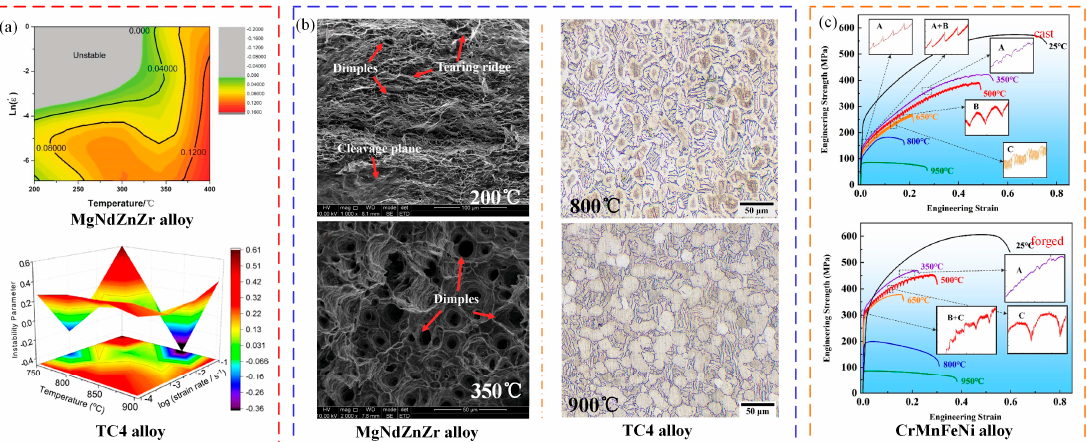
Figure 8. Deformation instability characteristics of di ff erent materials under hot tensile conditions: ( a ) hot processing diagrams of MgNdZnZr alloy and TC4 alloy; ( b ) fracture morphology of MgNdZnZr alloy and TC4 alloy at di ff erent temperatures [65,101]; ( c ) engineering stress–strain curves of CrMnFeNi high-entropy alloys, with as-cast and forged samples [103].